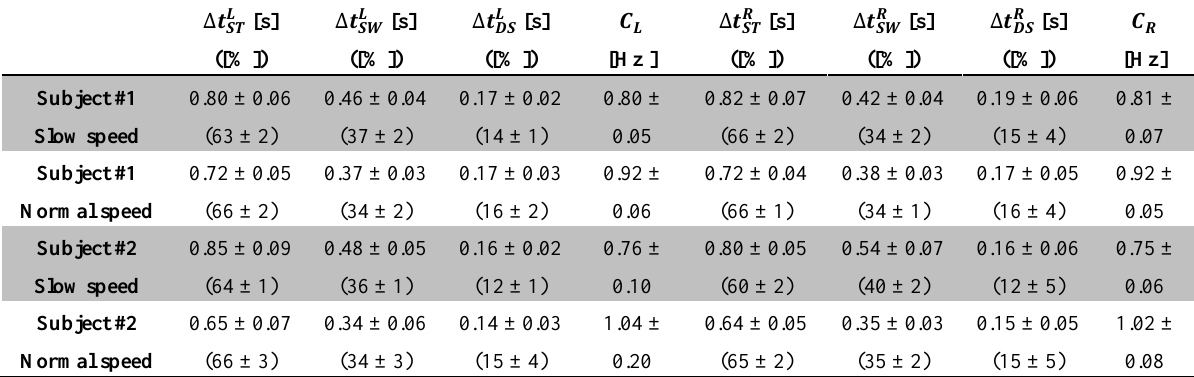
Table 1. Gait parameters: for all computed parameters we report the average value and the standard deviation ( ). , , , ,